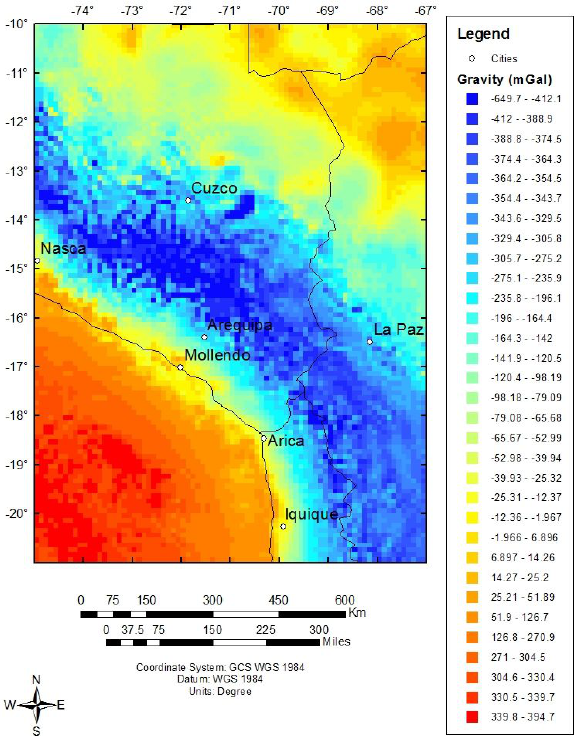
Figure 3: Complete Bouguer anomaly map of the Peru Chile sub- duction zone. The gravity data are from the EIGEN-6C4 geopotential model that includes terrestrial and satellite-derived gravity data (Förste et al., 2014). The EIGEN-6C4 model has degree and order of 2190 (spatial resolution ca. 8